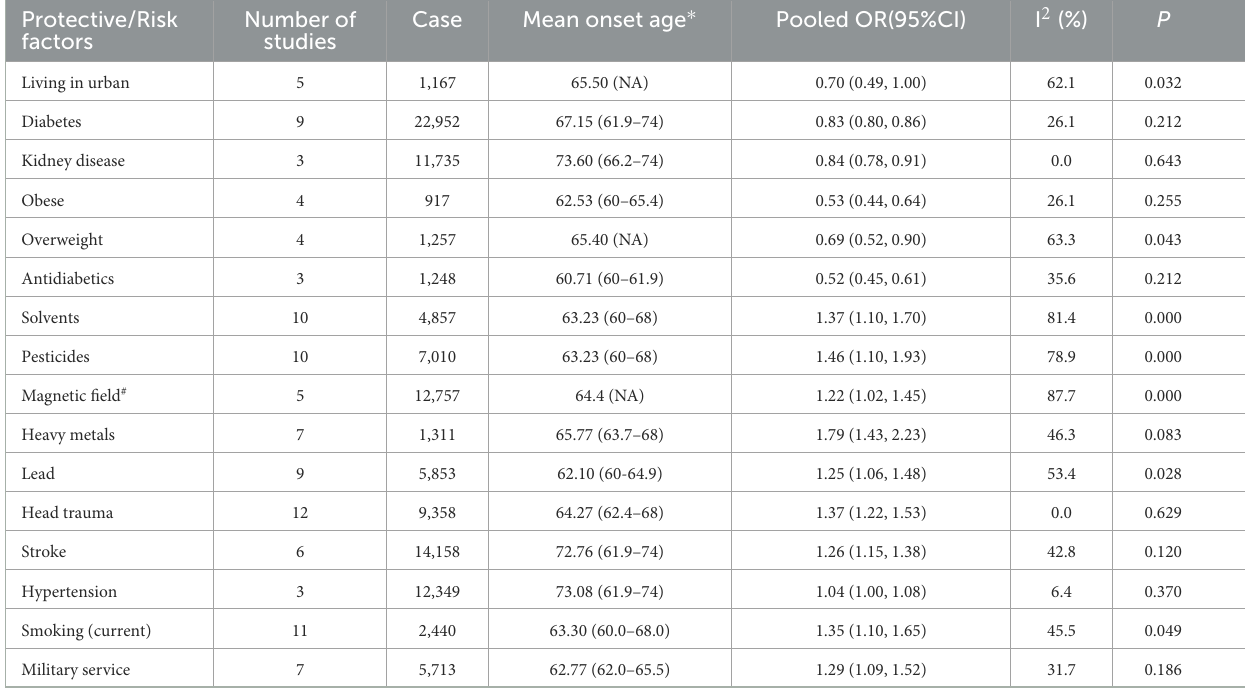
TABLE 1 Pooled odds ratio and heterogeneity statistics of positive and negative non-genetic associations with ALS. Protective/Risk